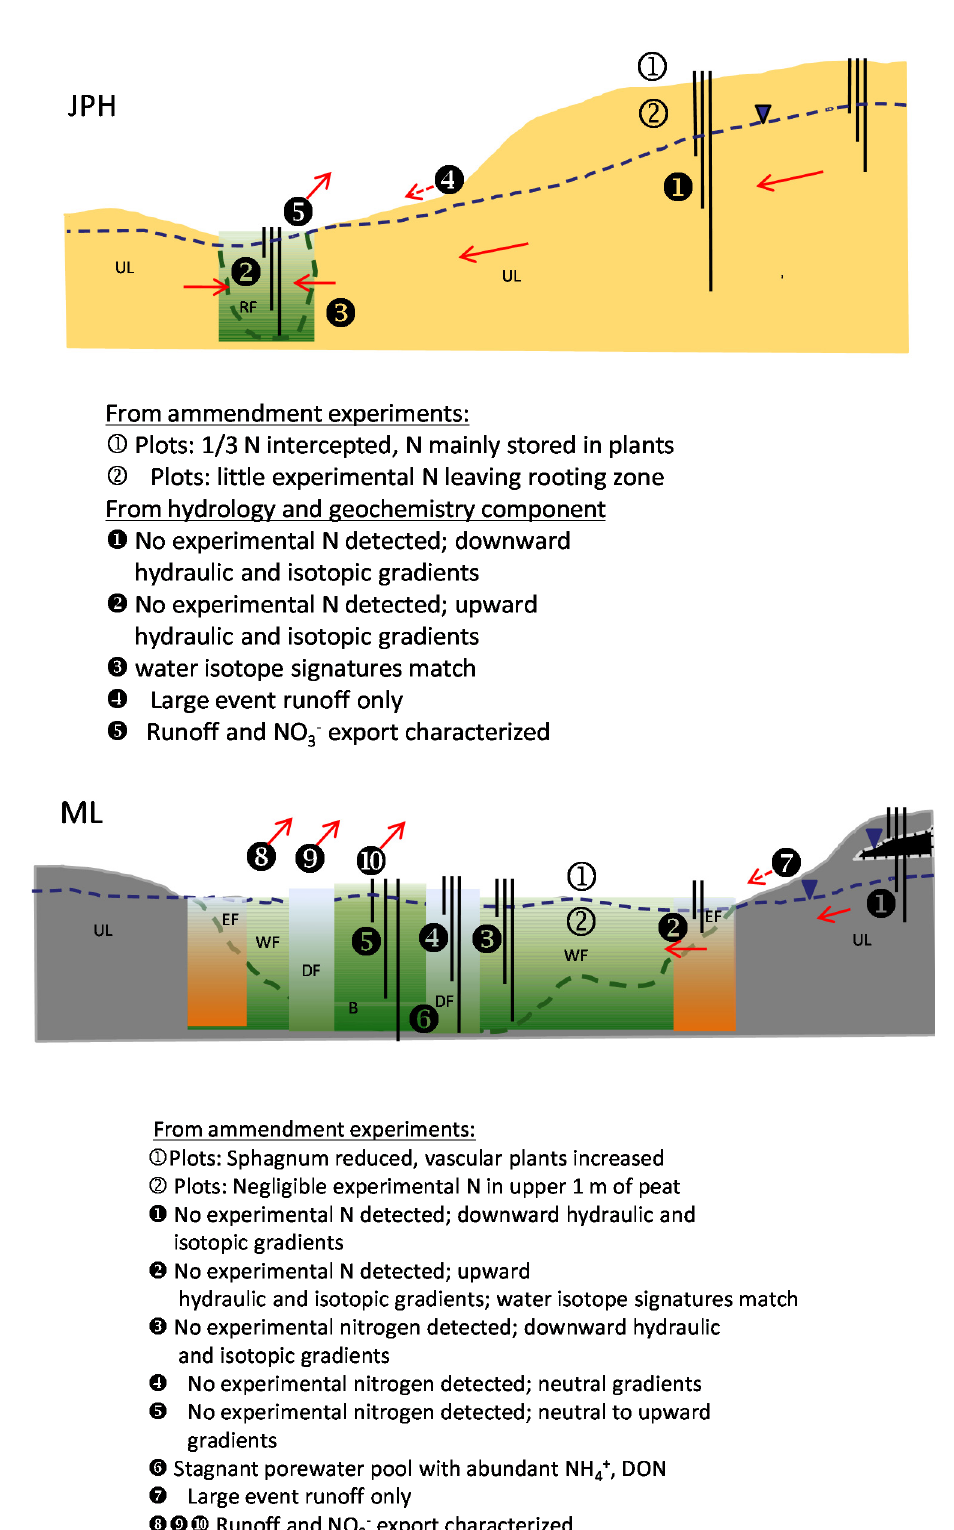
Figure 12. Conceptual model showing evidence of water and nitrogen flows at JPH and ML. UL—uplands, RF—rich fen, EF—edge fen, WF—wet fen, DF—dry fen, B—bog. Red arrows indicate water and nitrogen flows. See notes below each panel.